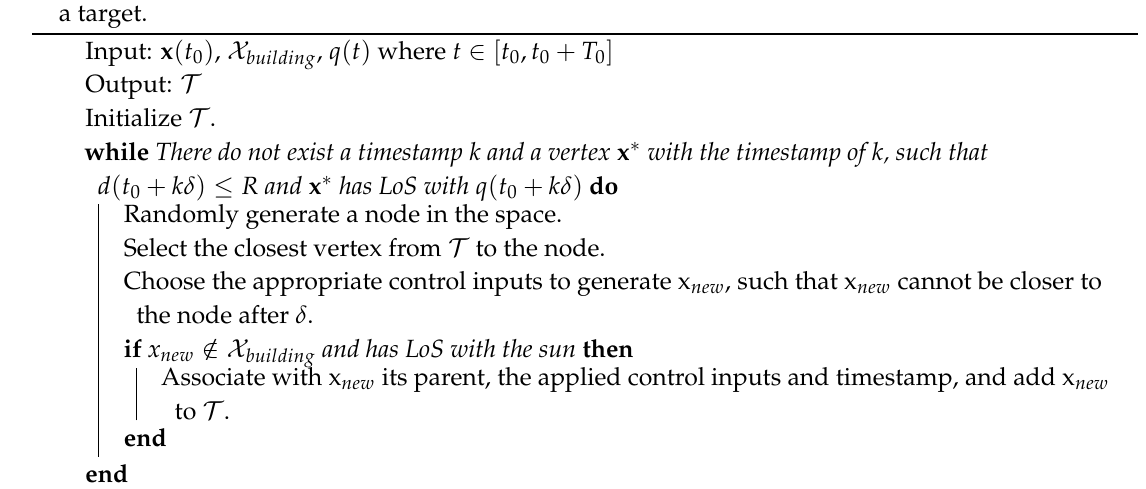
Algorithm 1: Rapidly-exploring random tree (RRT)-based path planning algorithm to intercept a target.